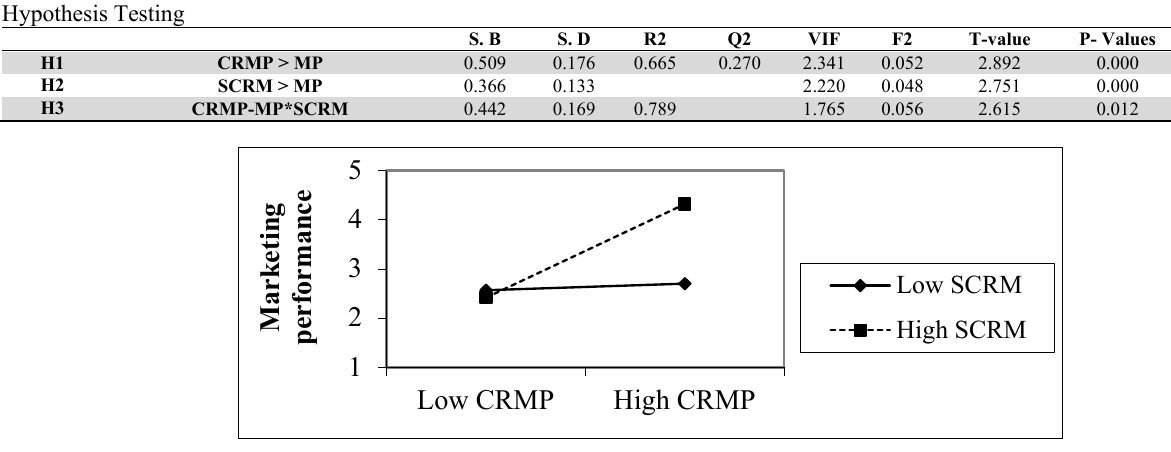
Fig. 3 . SCRM Moderator